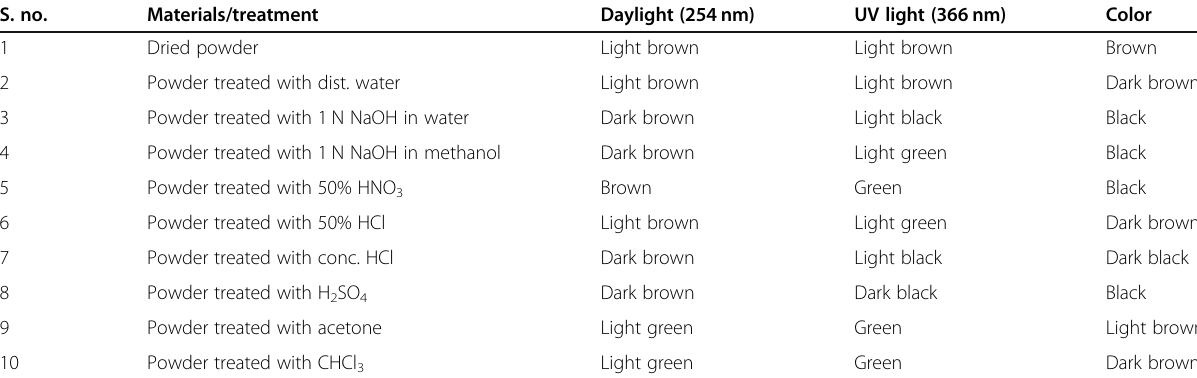
Table 2 Reaction of different reagents with powdered drugs S. no.